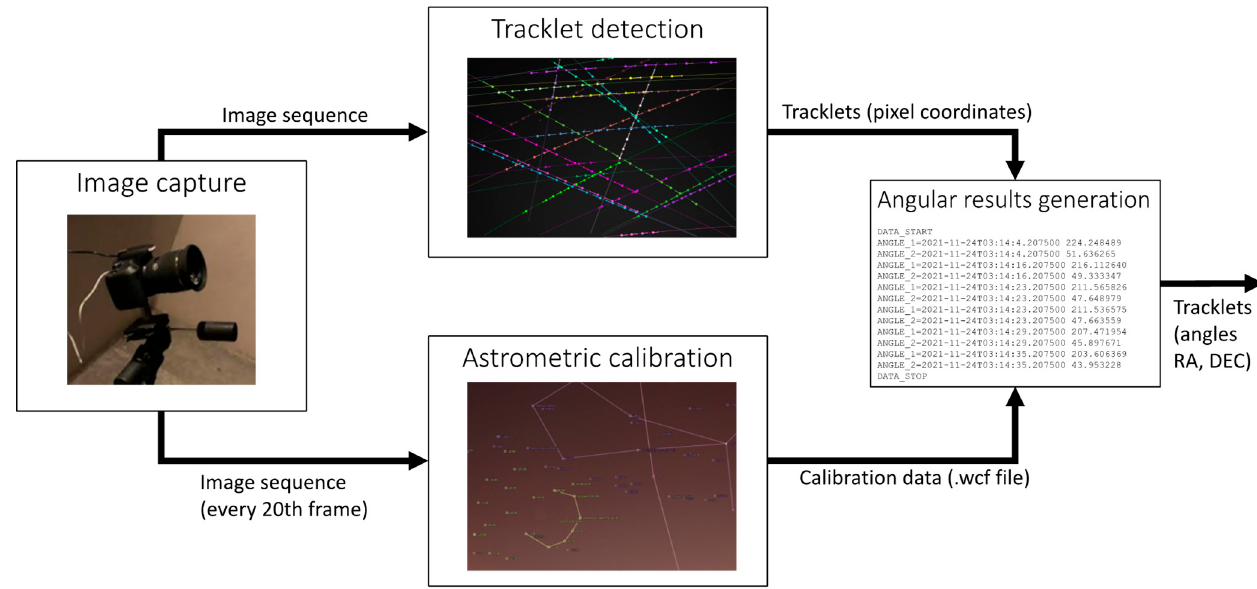
Figure 4. The software components of the LEO tracklet detection